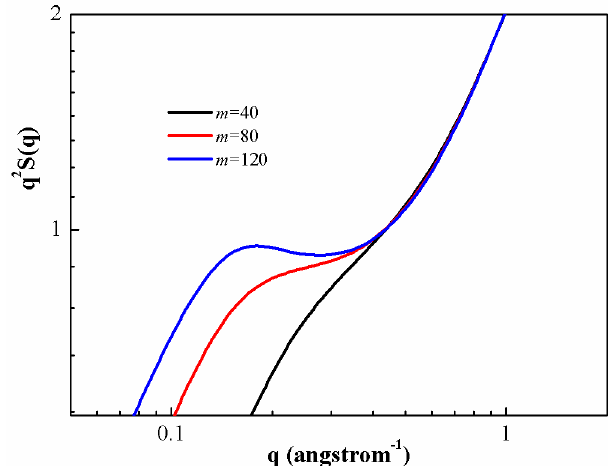
Figure 5. Structure factor of PS chain with three values of polymerization degree at 500 K.